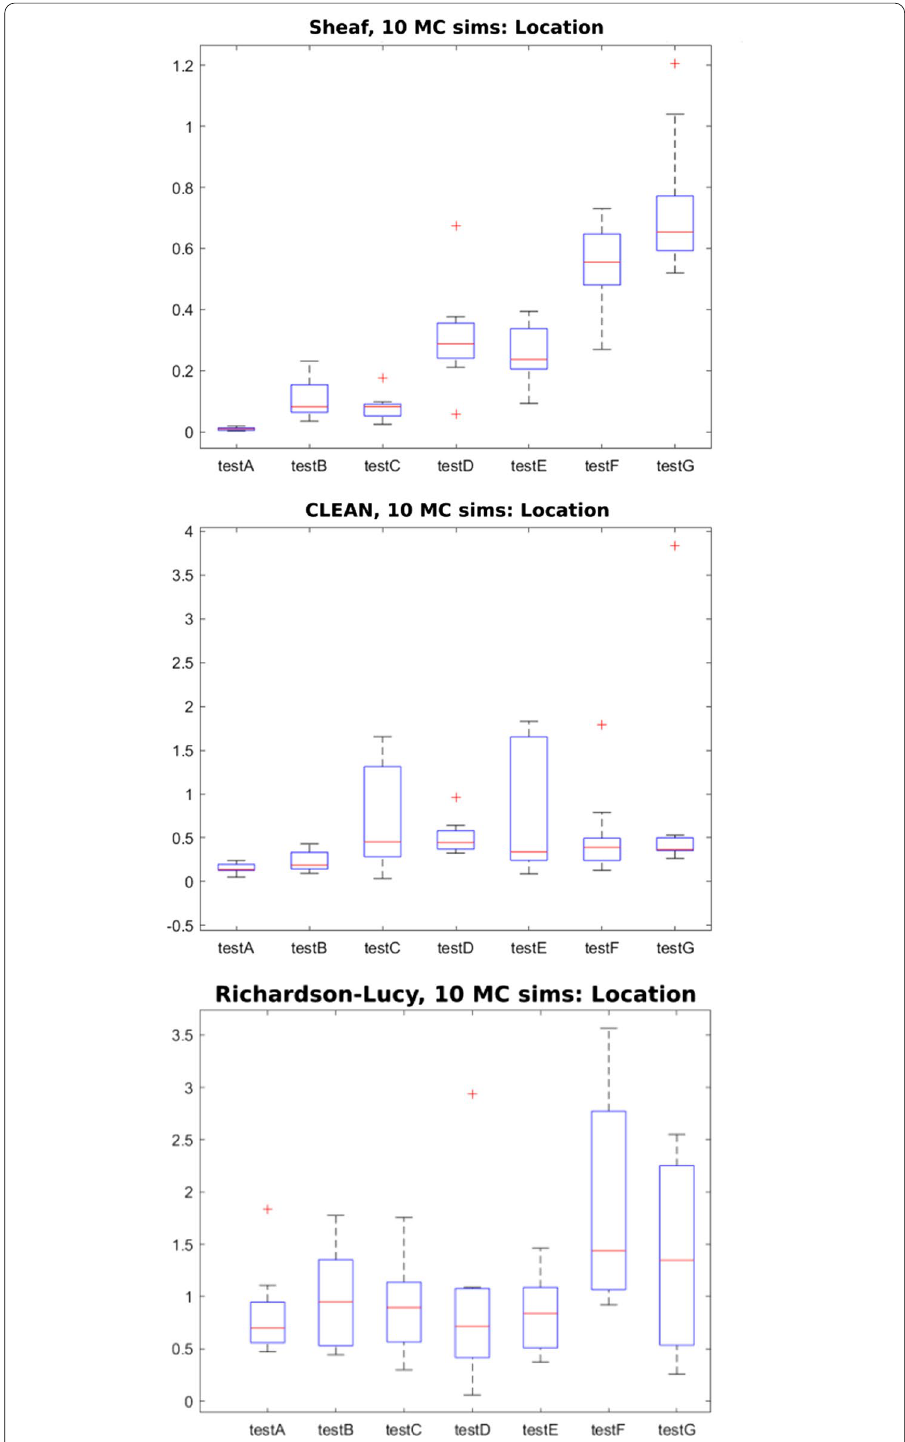
Fig. 10 Location root mean squared error (RMSE) of the sheaf, CLEAN, and Richardson–Lucy algorithms split by Test (see Table 1). The vertical scales differ between frames to emphasize